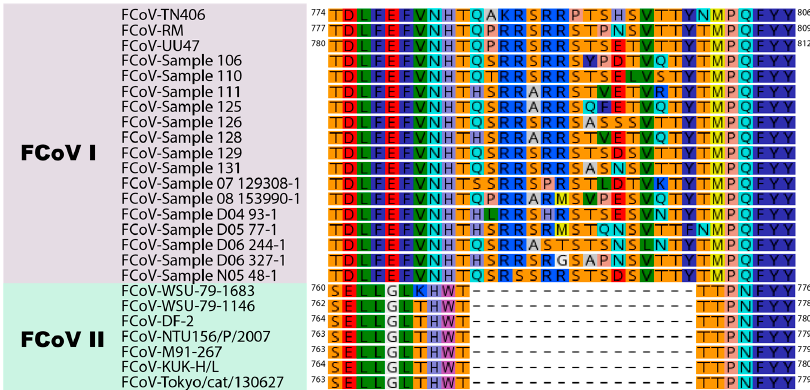
Figure 3. Alignment of the S1/S2 region of FCoV I and FCoV II strains. Sequences corresponding to the S1/S2 region of three FCoV type I strains (FCoV-RM, FCoV-UU47 and FCoV-TN406) and three FCoV type II strains (FCoV-DF-2, FCoV-WSU-79-1683 and FCoV-WSU-79-1146) reported in GenBank, and 15 FCoV type I sequences from clinical samples reported in the European Nucleotide Archive were aligned using the Geneious Prime 2019 (v.2019.2.3) software package (supplementary information 1). A 16 amino acid insertion including the S1/S2 cleavage site (6 amino acid) and a 10 amino acid flanking region was only observed in type I strains. FCoV type I sample are partial sequences, amino acid nomenclature cannot be displayed.